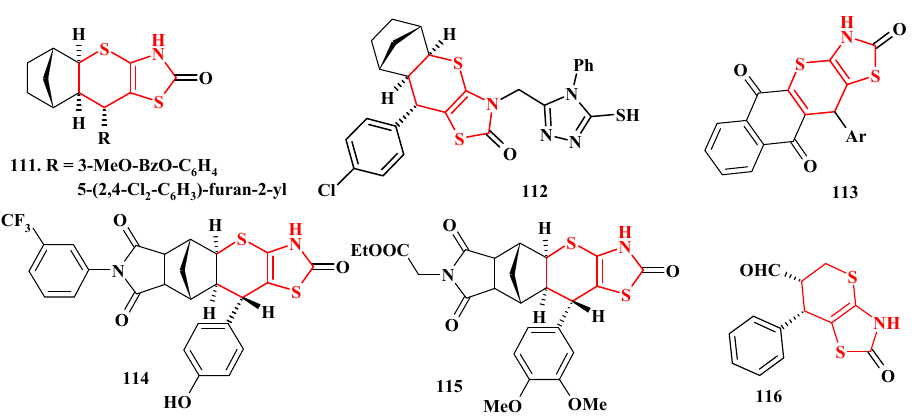
Figure 7. Thiopyrano[2,3- d ]thiazoles with anticancer activity in vitro.